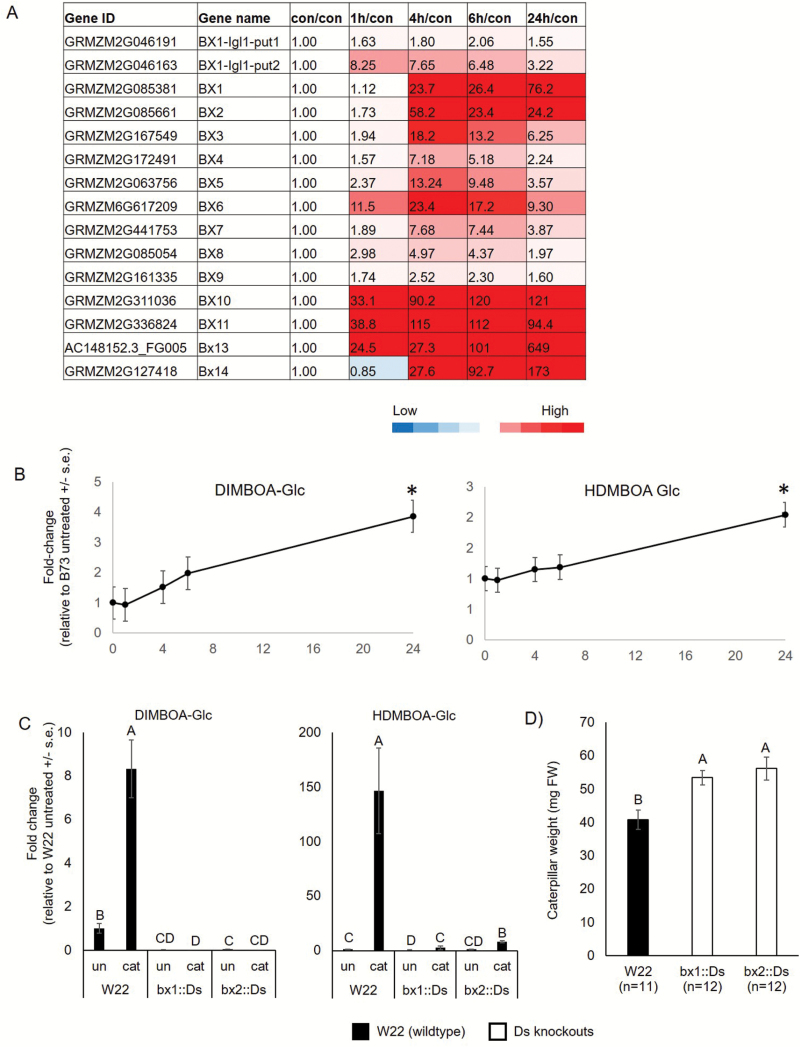
Effects of caterpillar feeding on benzoxazinoid-related genes and metabolites. (A) Heat map of gene expression and (B) DIMBOA-Glc and HDMBOA-Glc abundance over time after caterpillar feeding. Values are presented as fold change relative to untreated control. Mean±SE of n=4 for transcriptomic data, n=5 for metabolomic data). (C) Abundance of DIMBOA-Glc and HDMBOA-Glc in wild-type W22, bx1::Ds, and bx2::Ds, with and without caterpillar feeding. Different letters above the bars indicate significant differences, P<0.05, ANOVA followed by Tukey’s HSD test. (D) S. exigua caterpillar body weight after 4 d on wild-type W22, bx1::Ds, and bx2::Ds mutant plants. (This figure is available in color at JXB online.)